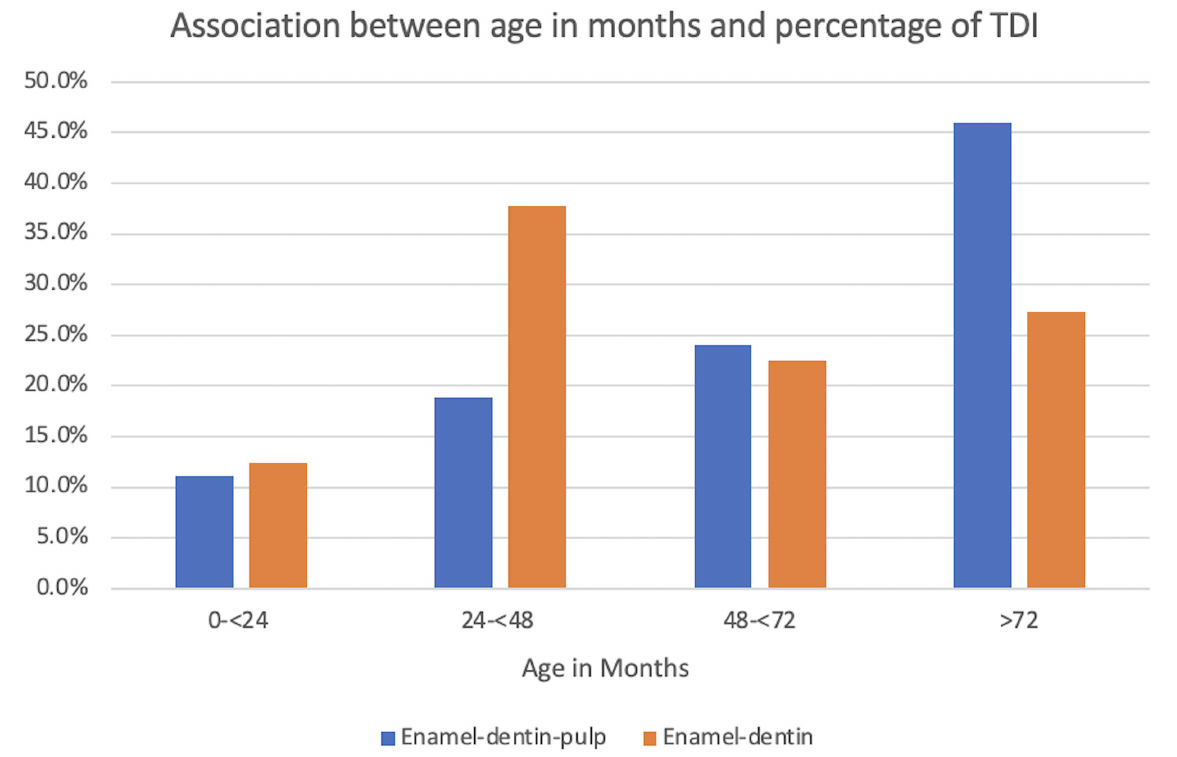
Teeth injured with enamel-dentin fractures in decreasing order were: the right maxillary canine tooth, the left maxillary canine tooth equally with the left mandibular canine tooth, the right mandibular canine tooth, and the right maxillary third incisor tooth. This study documented enamel-dentin-pulp